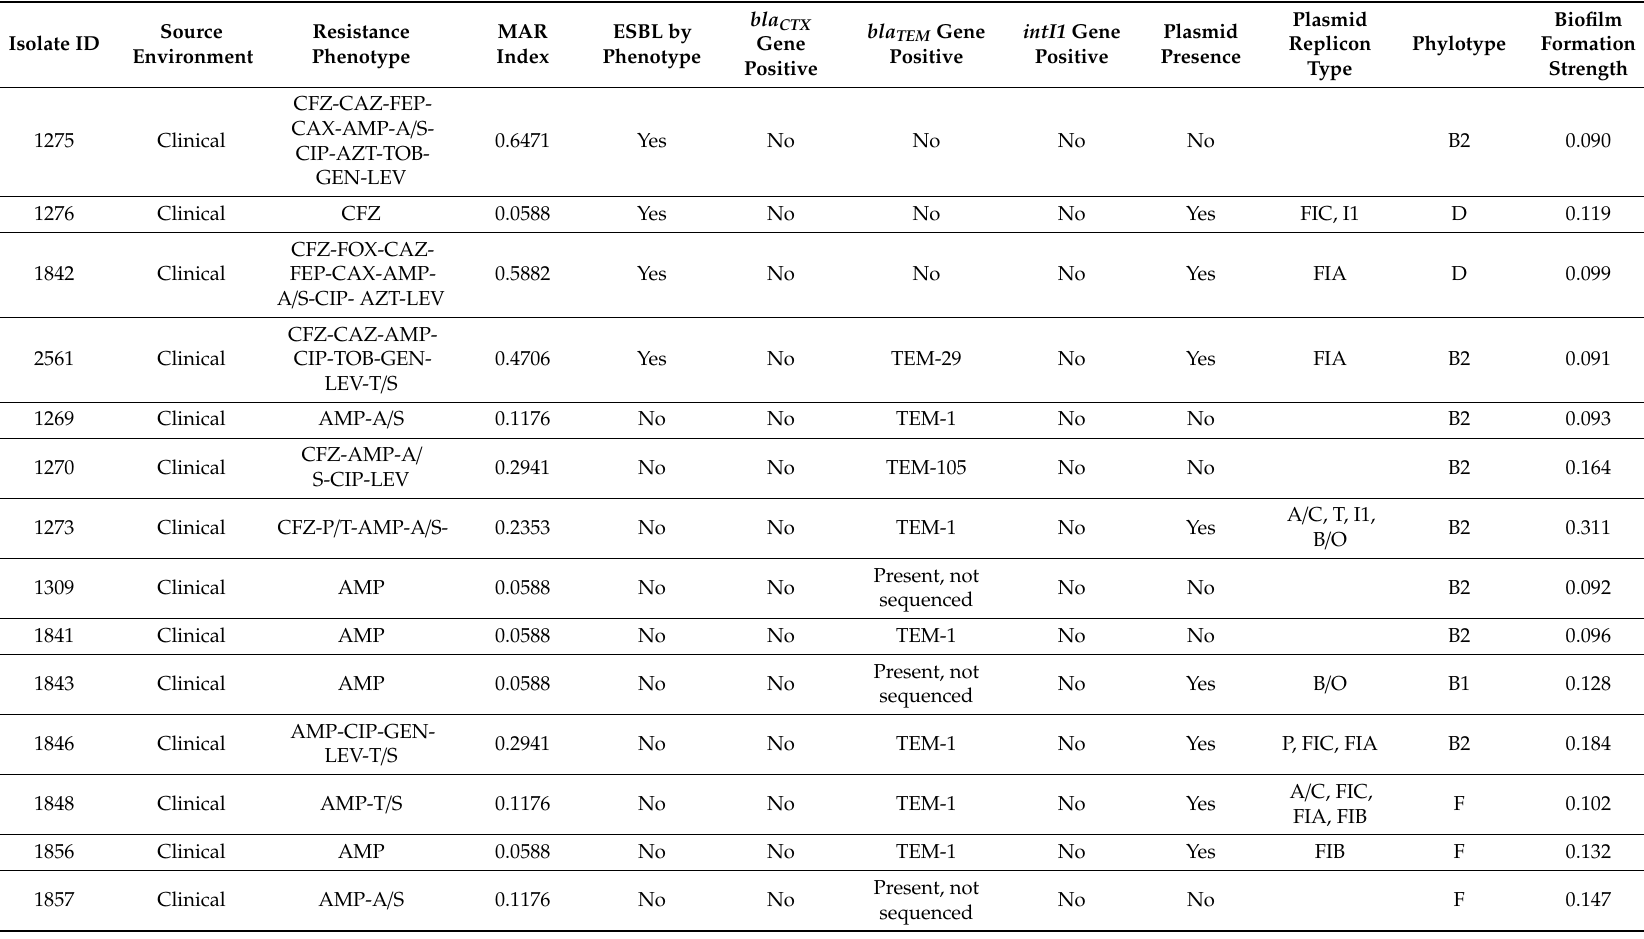
Table 2. Analyzed traits for E. coli isolates that were phenotype or genotypic ESBL producers or plasmid